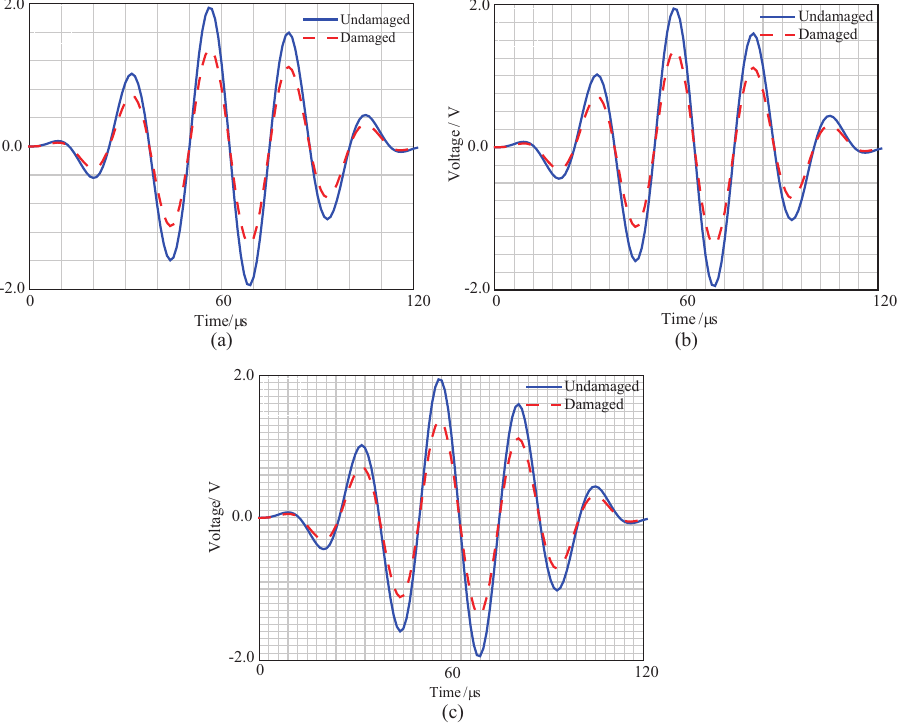
Fig. 1. Calculating box numbers at different box size for signals: (a) r = r 1 ; (b) r = r 2 ; (c) r = r 3 . ( r 1 > r 2 > r 3